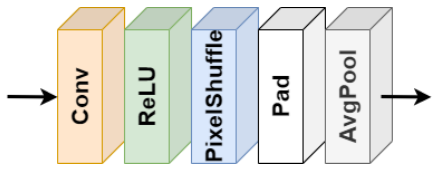
Figure 9. Pixel Shuffle layer with